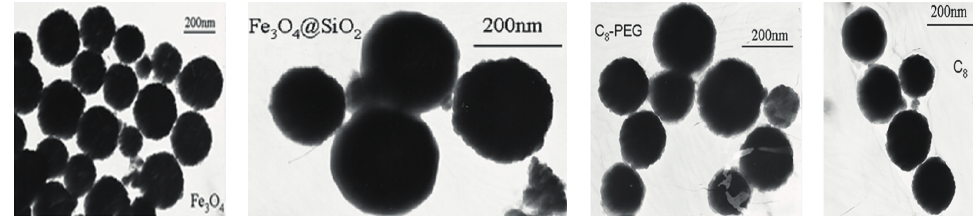
Figure 3: TEM of Fe 3 O 4 , Fe 3 O 4 @SiO 2 , C 8 , and C 8 -PEG.